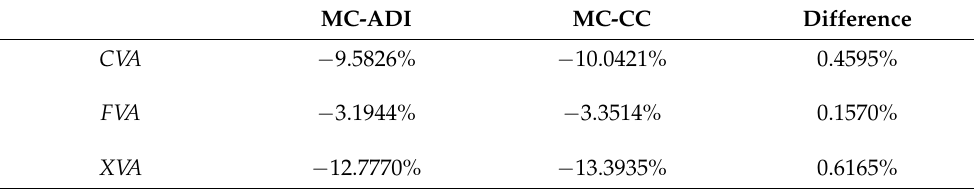
Table 3. CVA , FVA , and XVA of Basket Option , comparison and difference of the MC-ADI and MC-CC